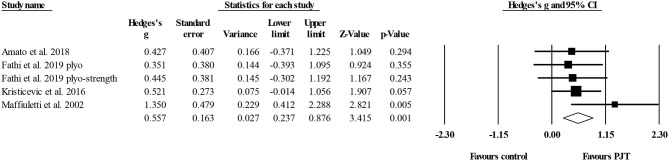
Forest plot of changes in squat jump performance in volleyball players participating in plyometric jump training (PJT) compared to controls. Values shown are effect sizes (Hedges's g) with 95% confidence intervals (CI). The size of the plotted squares reflects the statistical weight of the study.